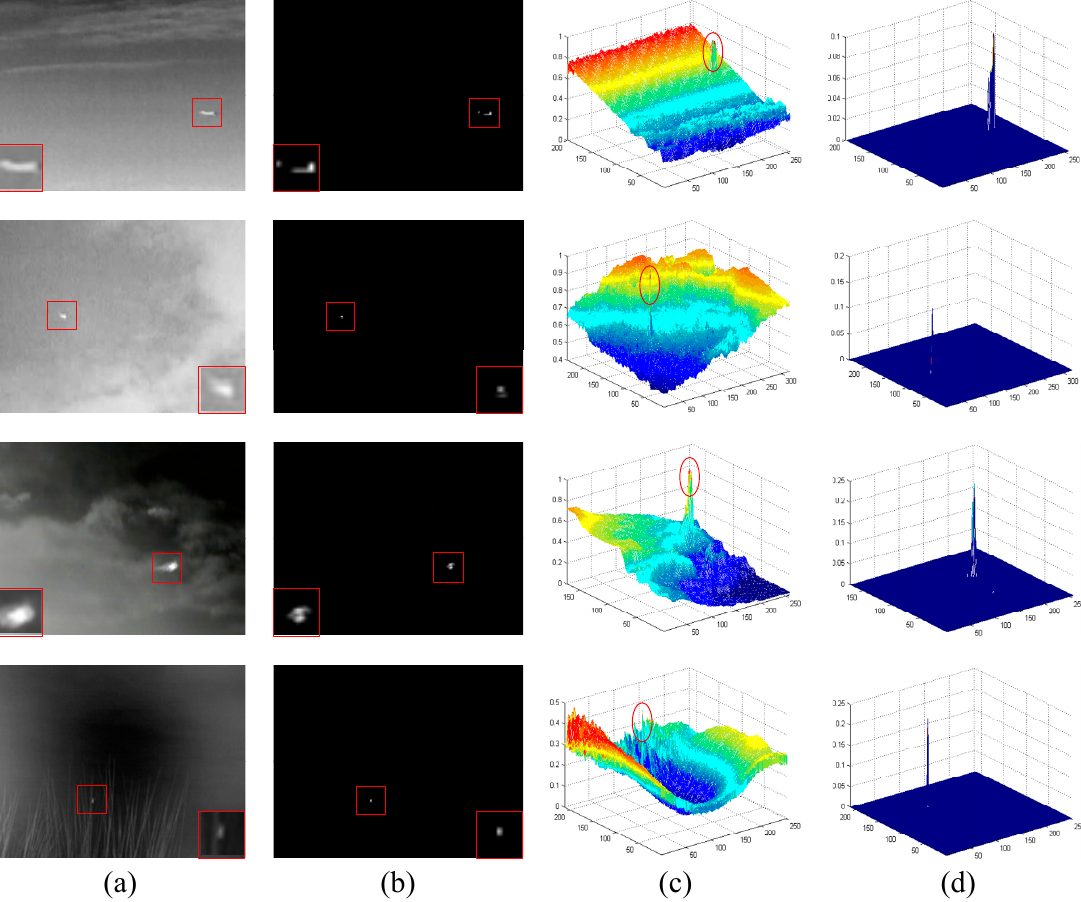
Figure 7. Display of the NOLC results of Seq1 to Seq4. (a) The original image; (b) the result of NOLC; (c) 3D display of (a); (d) 3D display of (b).